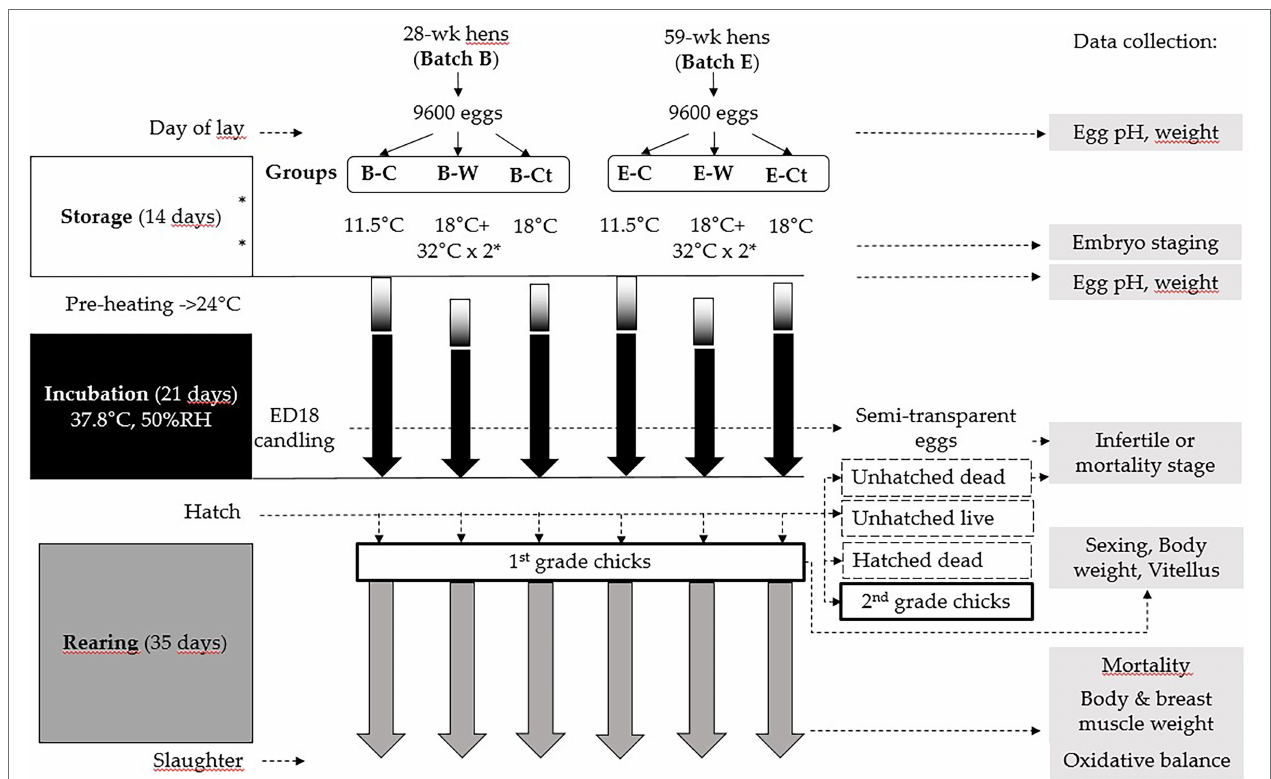
FIGURE 1 | Experiment workflow (B: eggs from breeder flock at the beginning of the laying period and E: end of the laying period). Ct: control group; C: cool storage; and W: warm storage. *pre-incubations (for groups W), dotted box: unhatched products, bold box: hatched